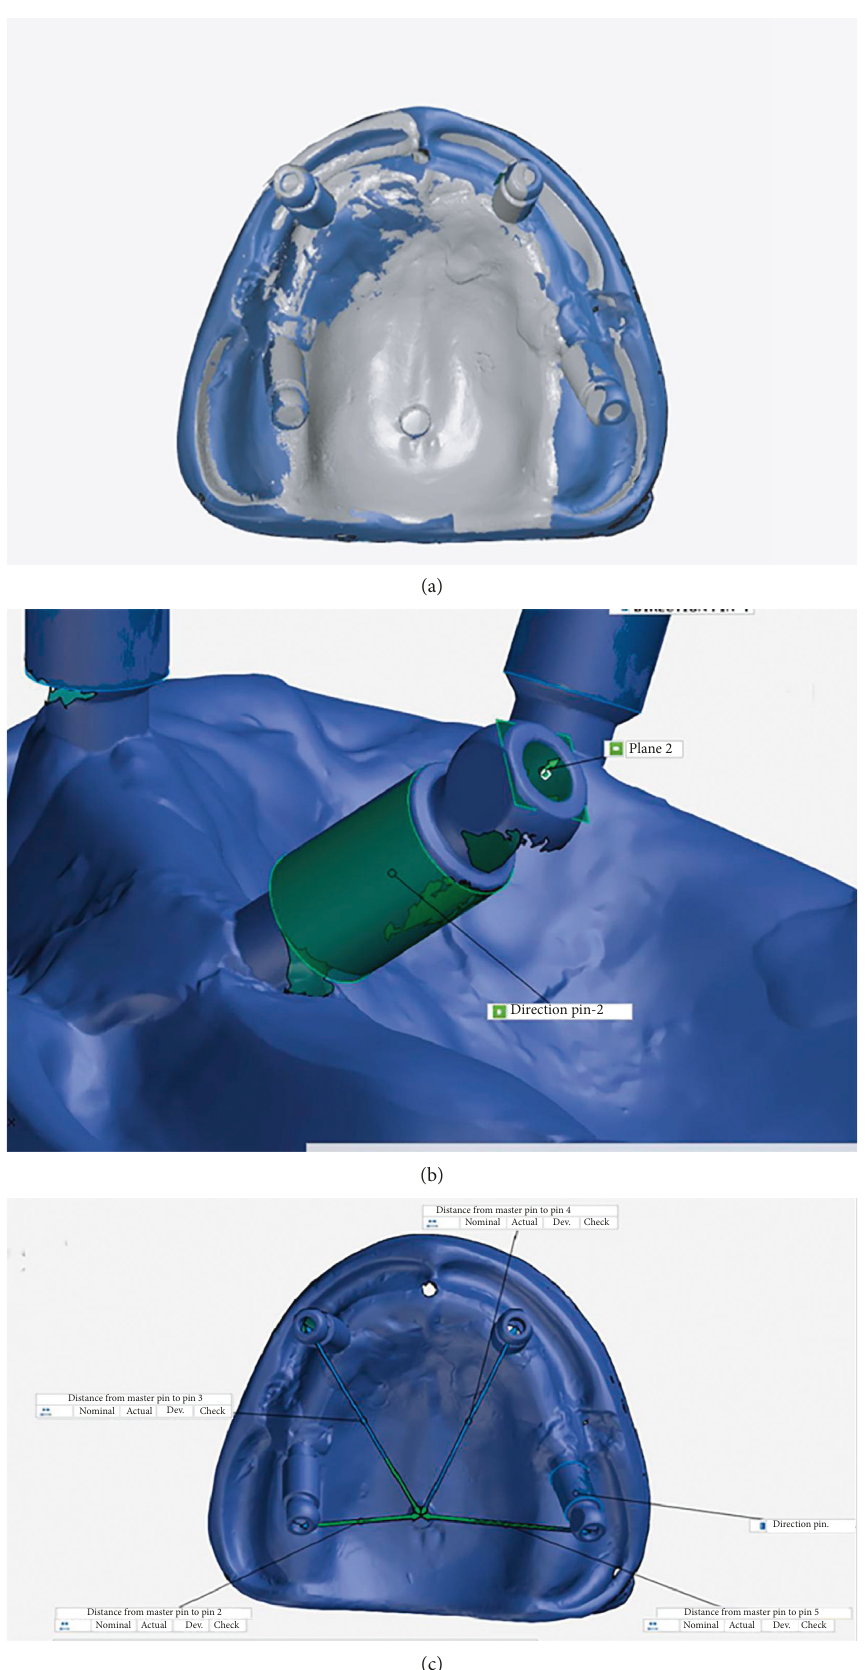
Figure 2: Digital impression measurements. (a) Superimposition of nominal and actual data. (b) Fitting plane and cylinder and intersecting point (green) which indicates implant position. (c) Linear